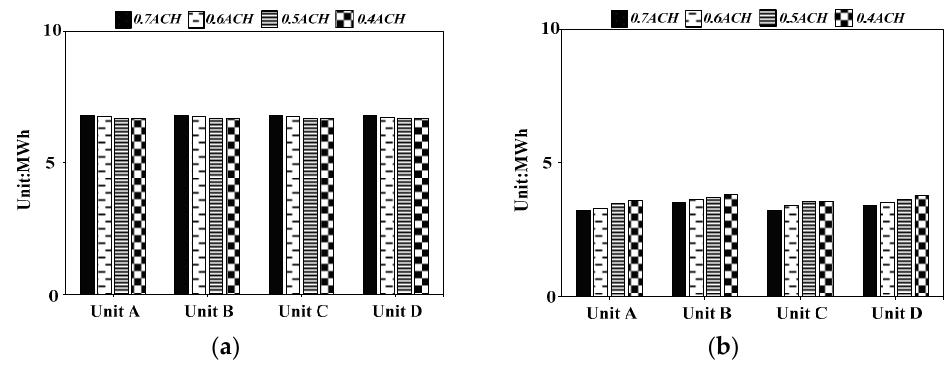
Figure 5. The effect of infiltration rates on building energy consumptions. ( a ) Heating loads; ( b ) Cooling loads.